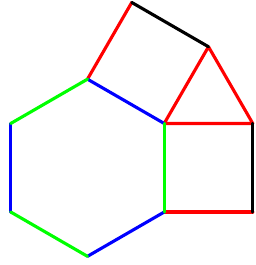
Fig. 3: Intermediate colouring of